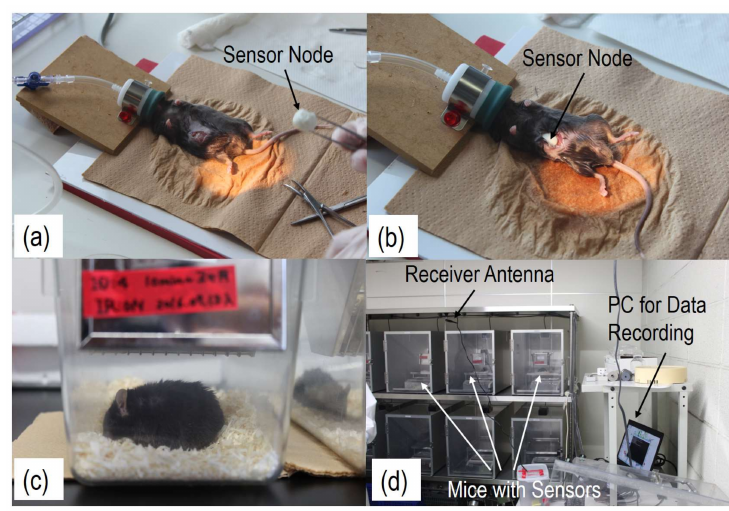
Figure 3. Photos of a mouse before ( a ), during ( b ), and after ( c ) implantation. Then, several mice were kept in cages to capture their body temperatures every few minutes ( d ).